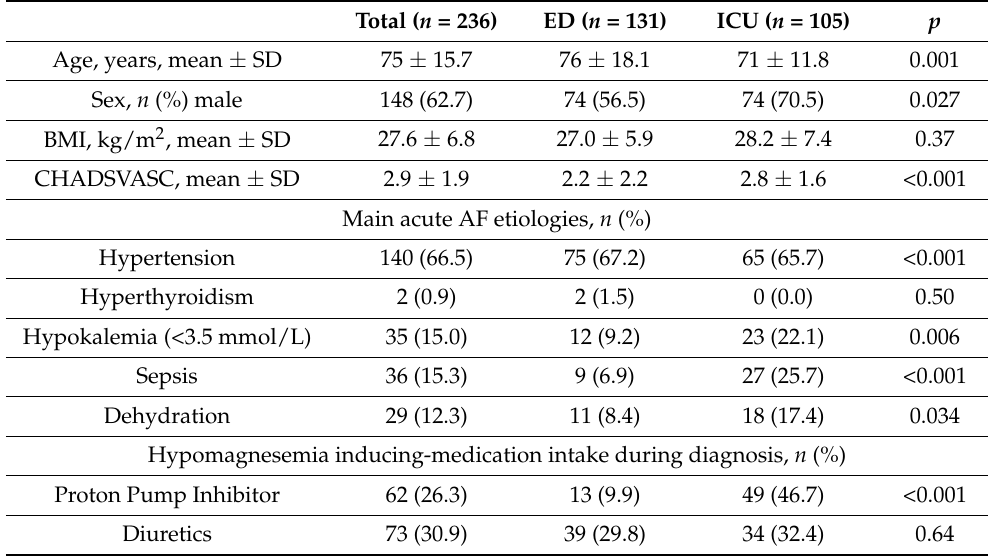
Table 1. Characteristics of the study population (de novo AF patients). Total ( n =